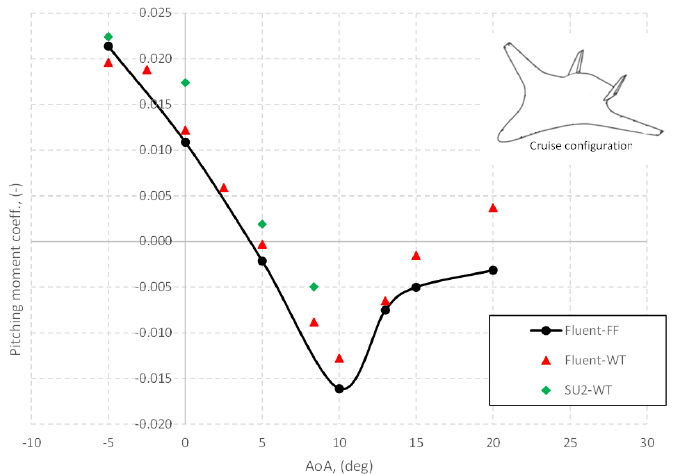
Figure 22. Pitching moment coefficients versus AoA, effect of Reynolds